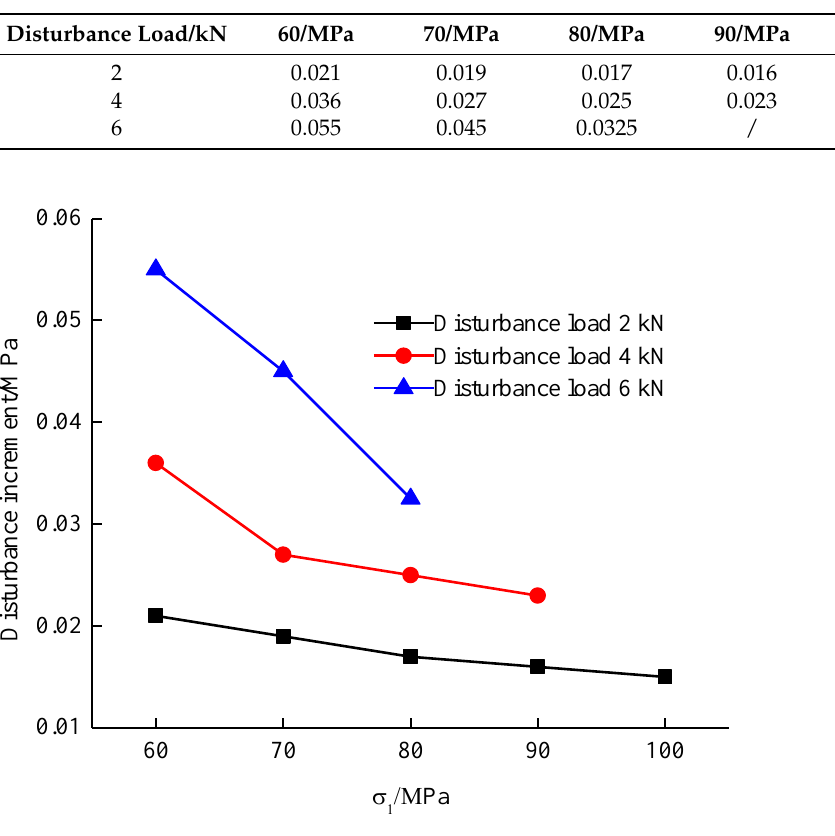
Table 3. Summary of the mechanical properties of the specimens under different disturbance